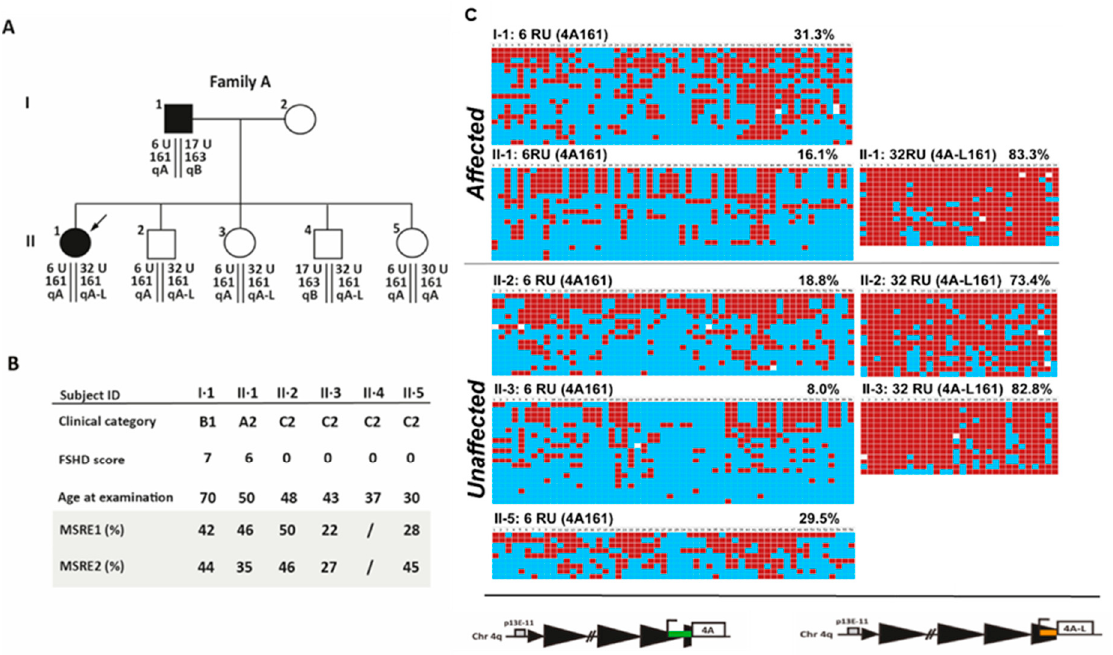
Figure 6. Analysis of the D4Z4 methylation status in family A. ( A ) Pedigree of family A. The genetic profile ( A ) or the clinical and epigenetic features ( B ) of each individual are reported. Filled symbols represent affected people ( C ) Genomic DNAs from the selected individuals were analyzed using the 4qA or 4qA-L BSS assay. The percentage DNA methylation for the Q1 is indicated. Red boxes indicate methylated CpGs, blue boxes indicate unmethylated CpGs, and white boxes indicate no CpG at the expected site.